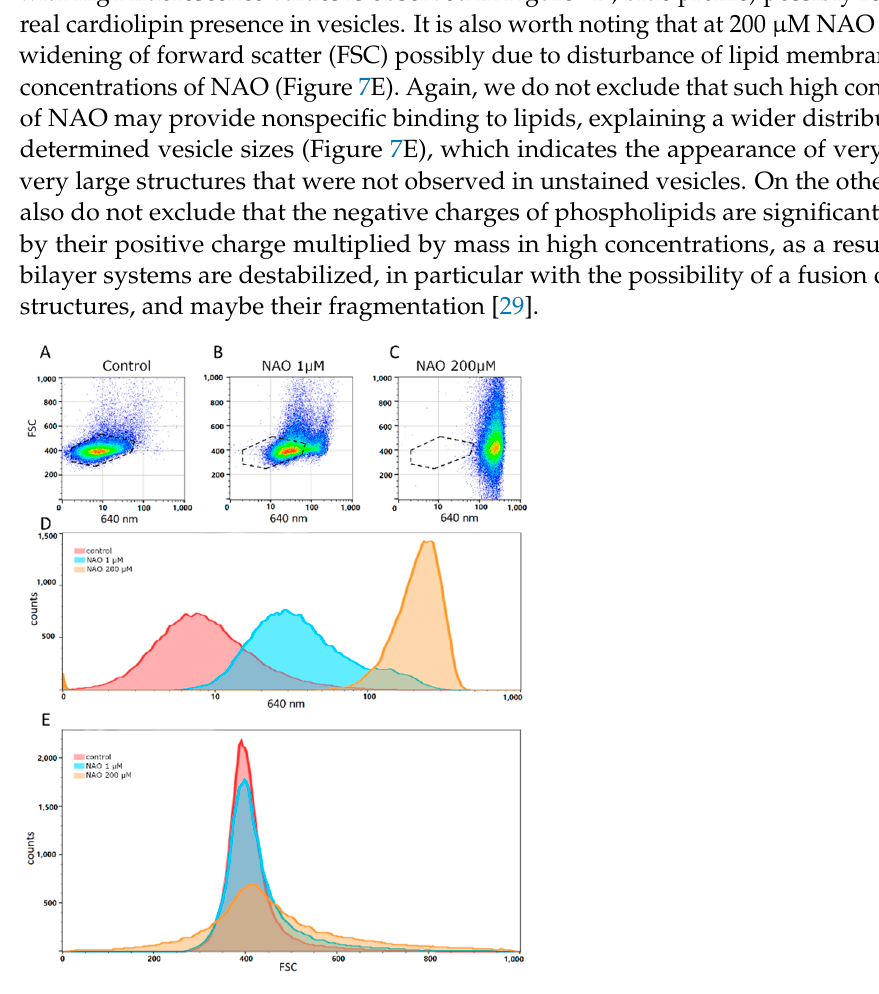
Figure 7. Flow cytometry analysis showing possible cardiolipin presence in ectosomes stained with 10-nonyl-acridine orange (NAO). ( A – C ) Size (y scale, FSC) versus fluorescent intensity (x scale, 640 nm fluorescence signal) dot-plot of control vesicles and those stained with 1 µ M and 200 µ M NAO. ( D ) Fluorescence (640 nm) distribution (histogram) in control vesicles and those stained with 1 and 200 µ M NAO. Note the presence of a high fluorescent subpopulation in the 1 µ M NAO group, which possibly indicates presence of cardiolipin. ( E ) Size (FSC) distribution in control vesicles, and those stained with 1 μ M and 200 μ M NAO.